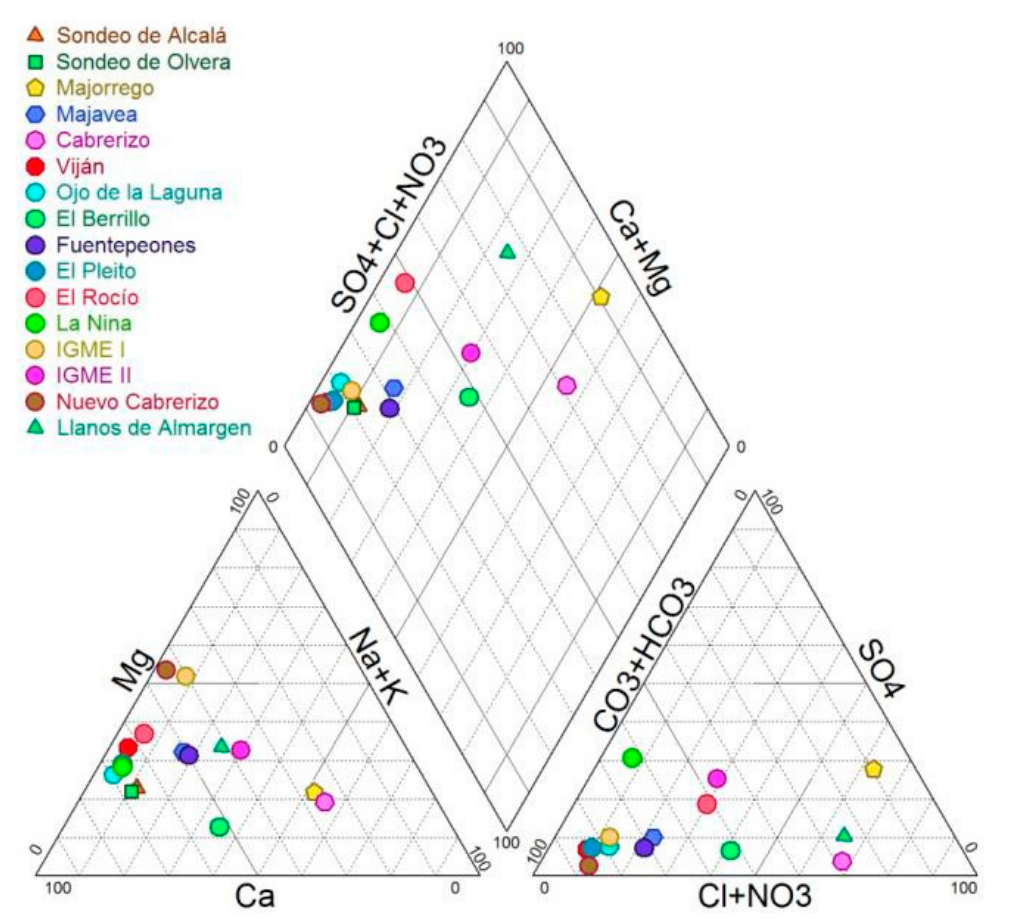
Figure 4. Piper diagram with maximum concentrations.